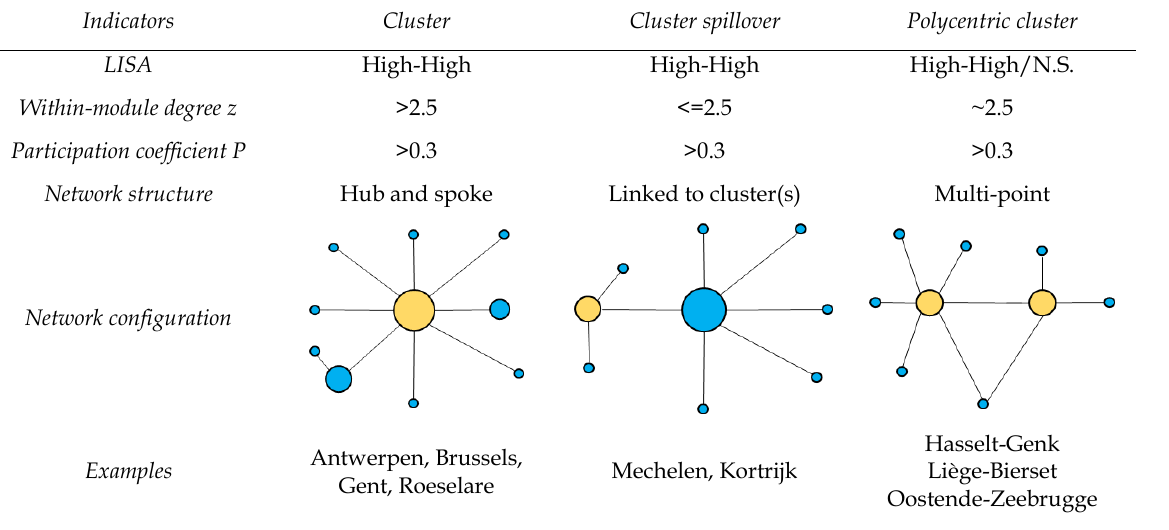
Table 4: Typology of logistics